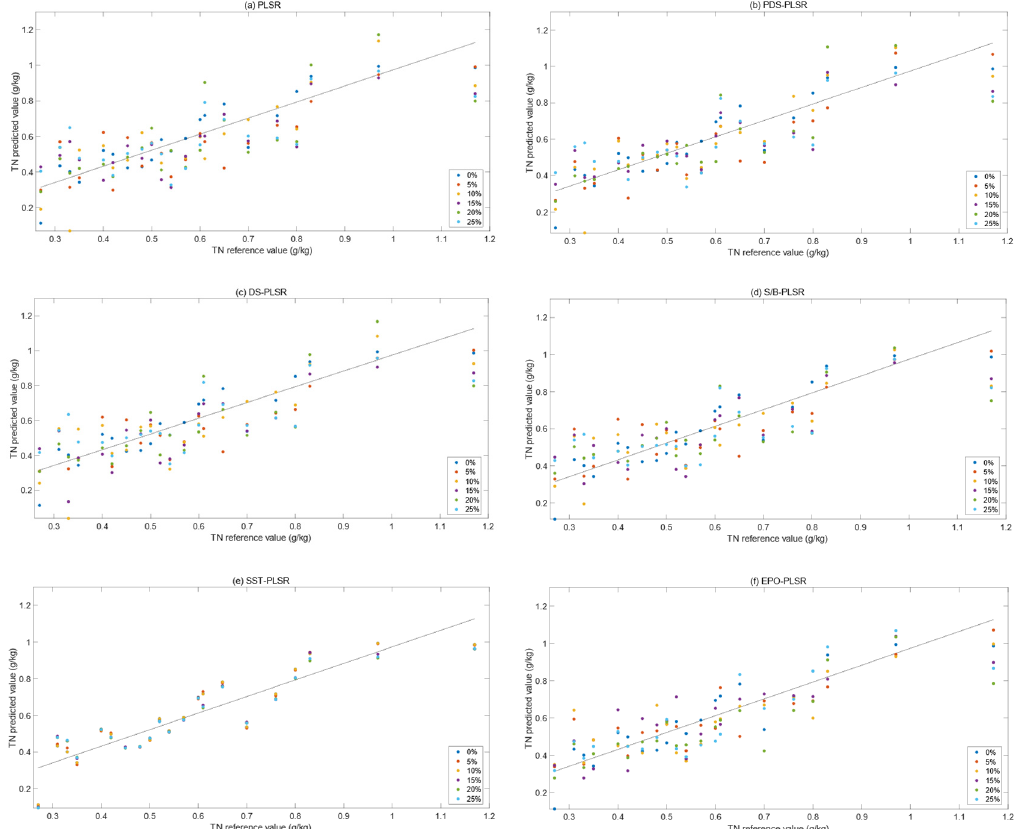
Figure 7. Comparison of reference values (the values of TN content obtained by the Kjeldahl method) for soil TN content with model-validated predictions using different models for soils with 0% (dry soil), 5%, 10%, 15%, 20%, and 25% moisture content: ( a ) PLSR, ( b ) PDS–PLSR, ( c ) DS–PLSR, ( d ) S/B–PLSR, ( e ) SST–PLSR, ( f ) EPO–PLSR.